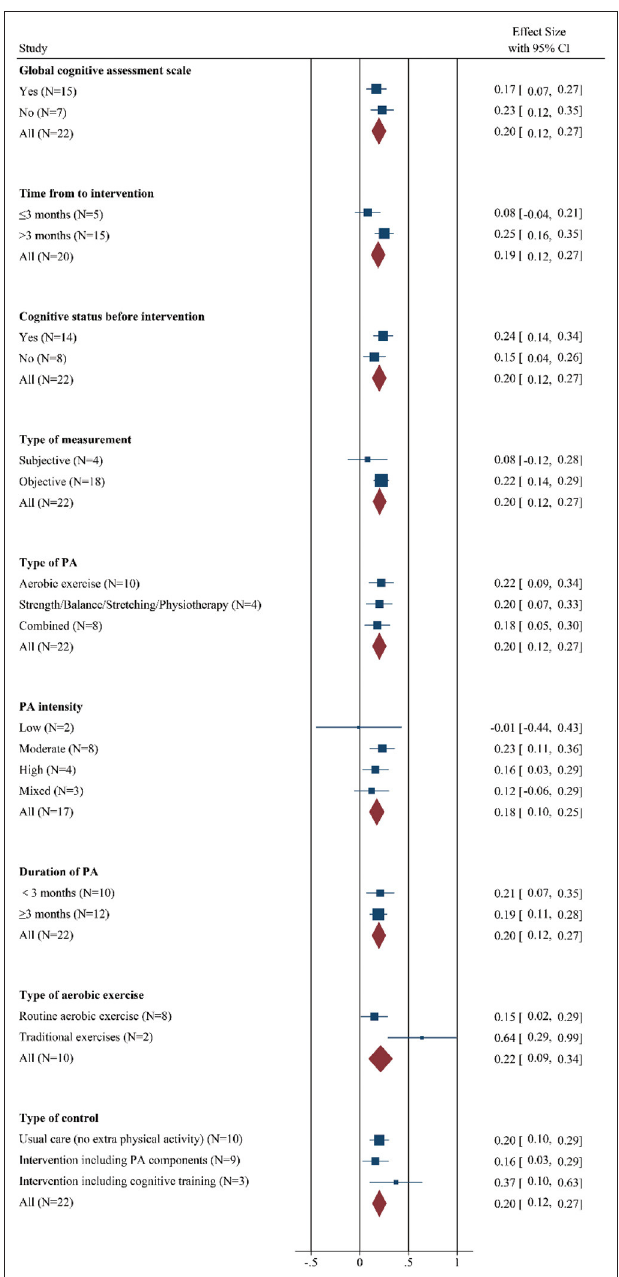
FIGURE 3 | Forest plot of meta-analysis in the effect of regulatory factors on the global cognitive improvement by PA. Positive values of pooled effect size represented that PA improved cognitive performance. CI, confidence interval; PA, physical